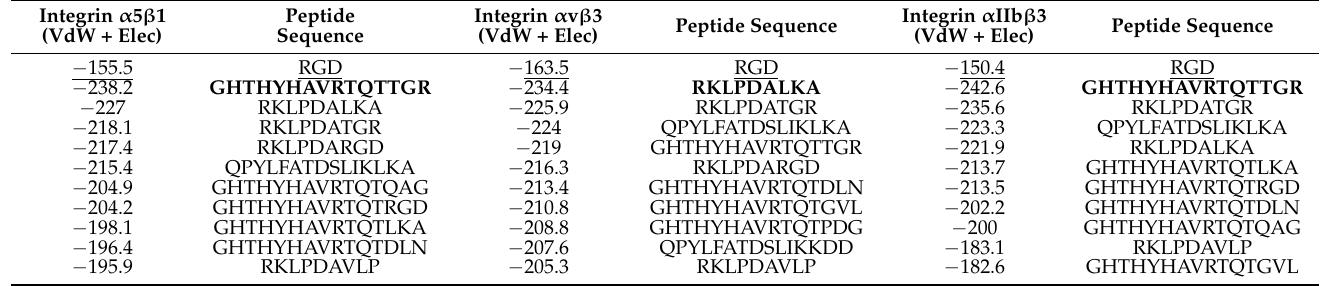
Table 1. Ten peptides that demonstrated the higher affinity binding for each integrin. The docking analysis measures the affinity binding of the integrin–peptide complexes by the analysis of van der Waals and electrostatic interactions (VdW + Elec). The lower the cluster score, the greater the affinity. The biological ligand of the integrins (RGD motif) is underlined and is meant to serve as a comparison parameter. The peptide that presented the higher affinity binding is highlighted in